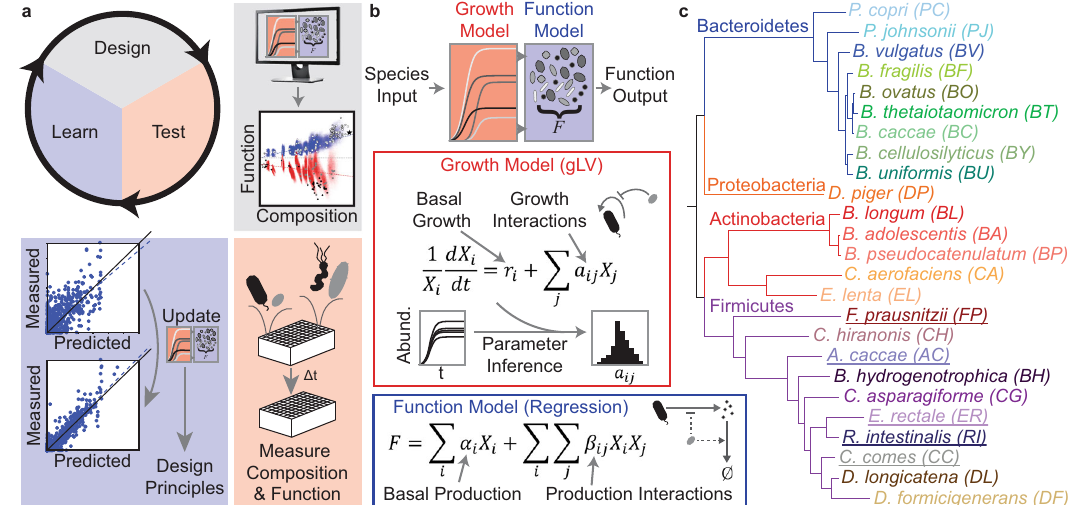
Fig. 1 Iterative modeling framework to predict microbial community assembly and metabolic function. a Two-stage modeling framework for predicting community assembly and function. The generalized Lotka – Volterra model (gLV) represents community dynamics. A Bayesian Inference approach was used to determine parameter uncertainties due to biological and technical variability. A linear regression model with interactions maps assembled community composition to metabolite concentration. Combining these two models enables prediction of a probability distribution of metabolite concentration from initial species abundances. b Design – Test – Learn cycle for model development. First, we use our model to explore the design space of possible experiments (i.e. different initial conditions of species presence/absence) and design communities that span a desired range of metabolite concentrations. Next, we use high-throughput experiments to measure species abundance and metabolite concentration. Finally, we evaluate the model ’ s predictive capability and infer an updated set of parameters based on the new experimental measurements. c Phylogenetic tree of the synthetic human gut microbiome composed of 25 highly prevalent and diverse species. Branch color indicates phylum and underlined species denote butyrate